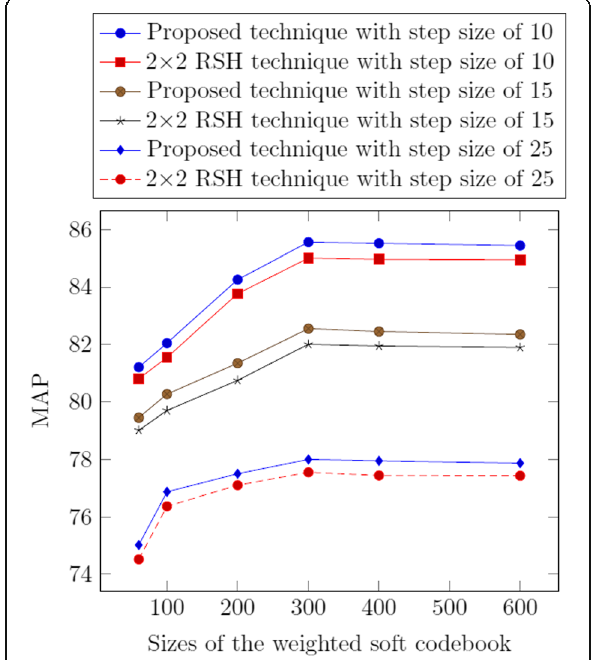
Fig. 11 Effect on the MAP performance by varying weighted soft codebook sizes on the image benchmark of the Corel-1.5K